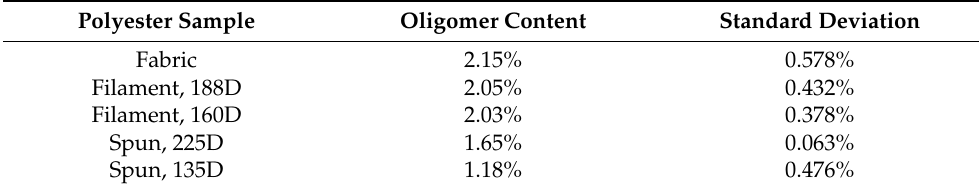
Table 2. Oligomer contents of different polyester